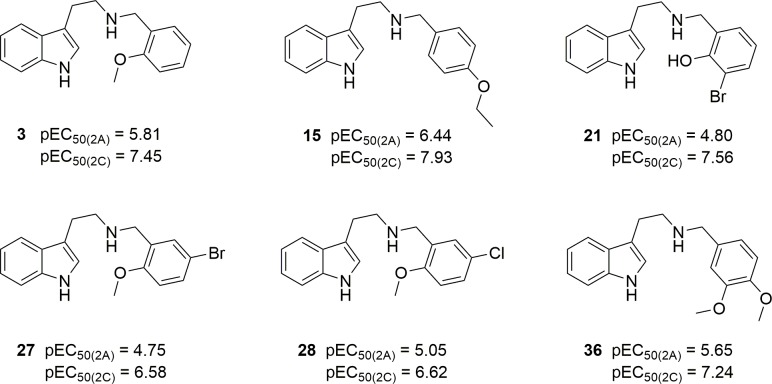
5-HT2C-selective N-benzyltryptamines.